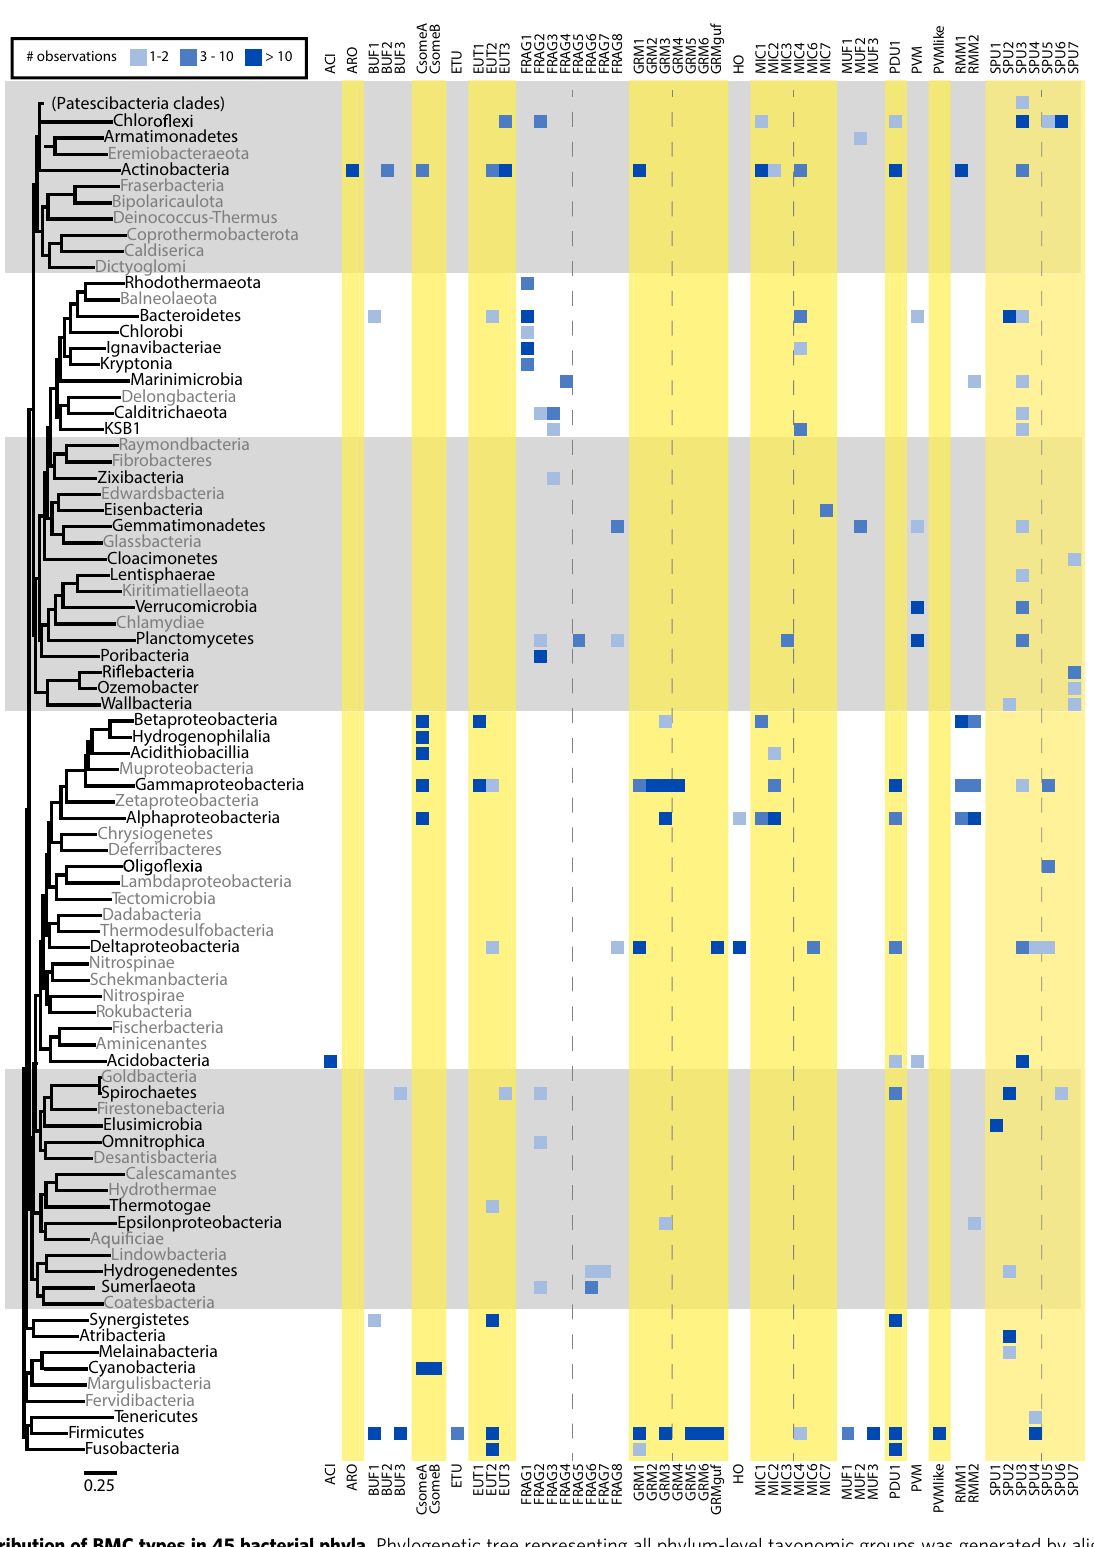
Fig. 4 Distribution of BMC types in 45 bacterial phyla. Phylogenetic tree representing all phylum-level taxonomic groups was generated by aligning a set of 56 different marker proteins. Phyla lacking BMC loci shown in gray and different numbers of BMCs in blue. Alternate yellow/gray blocks and dashed lines are added for visual